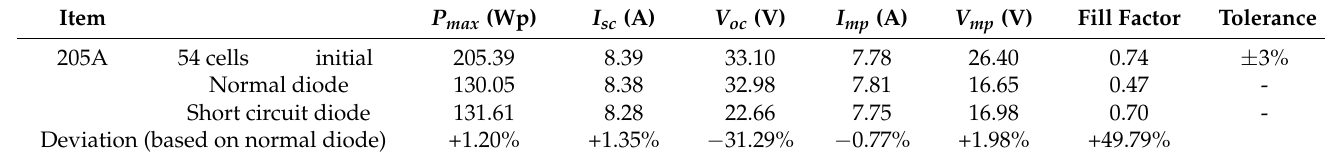
Table 5. Electrical data before and after replacement of short-circuit diode (205A).